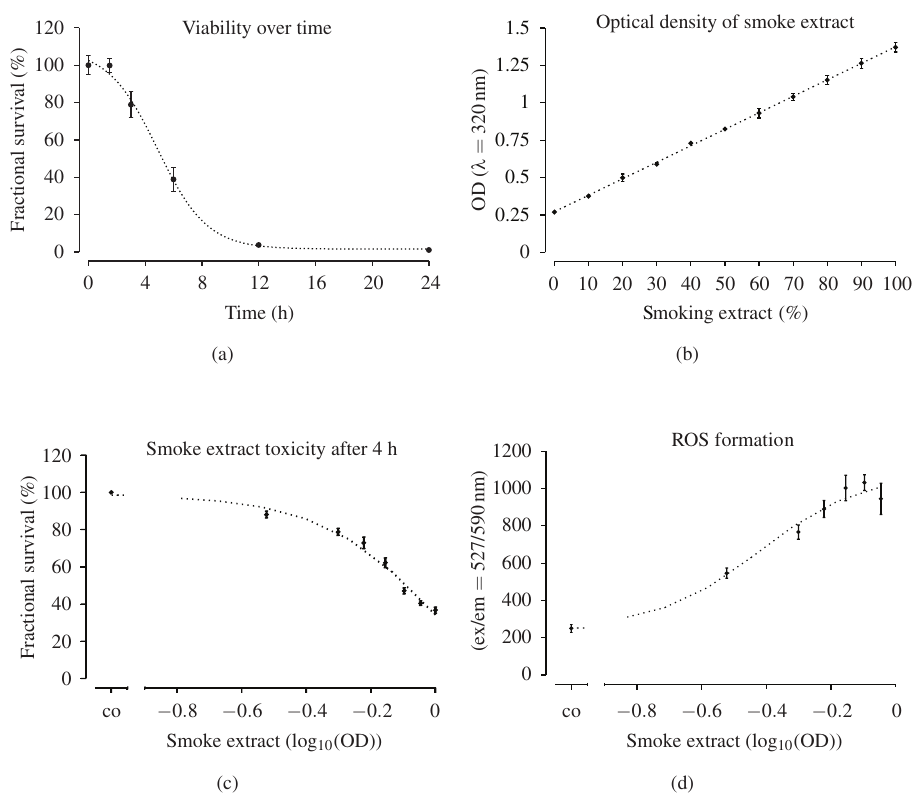
FIGURE 1: CSM damages primary human osteoblasts in a time- and concentration-dependent manner. (a) Primary human osteoblasts ( N = 3 , n = 6 ) were treated with concentrated CSM for 0, 1.5, 3, 6, 12, and 24 h. After stimulation viability was determined by resazurin conversion. (b) The optical density of different dilutions (0, 10, 20, 30, 40, 50, 60, 70, 80, 90, and 100 % ) of CSM was determined at λ = 320 nm (OD 320 ). (c) The same dilutions were tested for their toxic effect after 4 h stimulation (EC 50 ≈ 0.75 OD 320 ). (d) After 15 min CSM induces significantly ( P < 0 . 01 from 50 % CSM on) the production of ROS in primary human osteoblasts ( N = 3 , n = 4